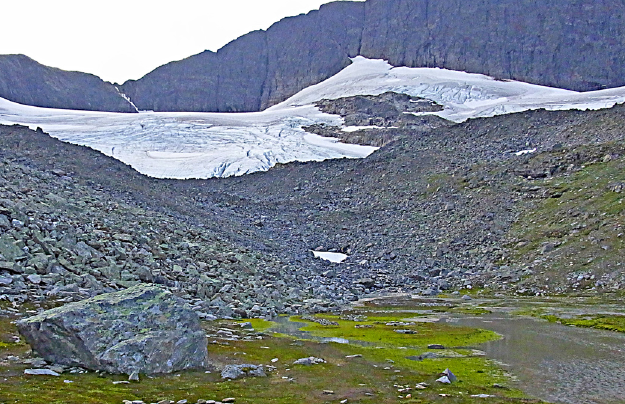
Figure 3: Helagsglaciären (1) viewed westwards from